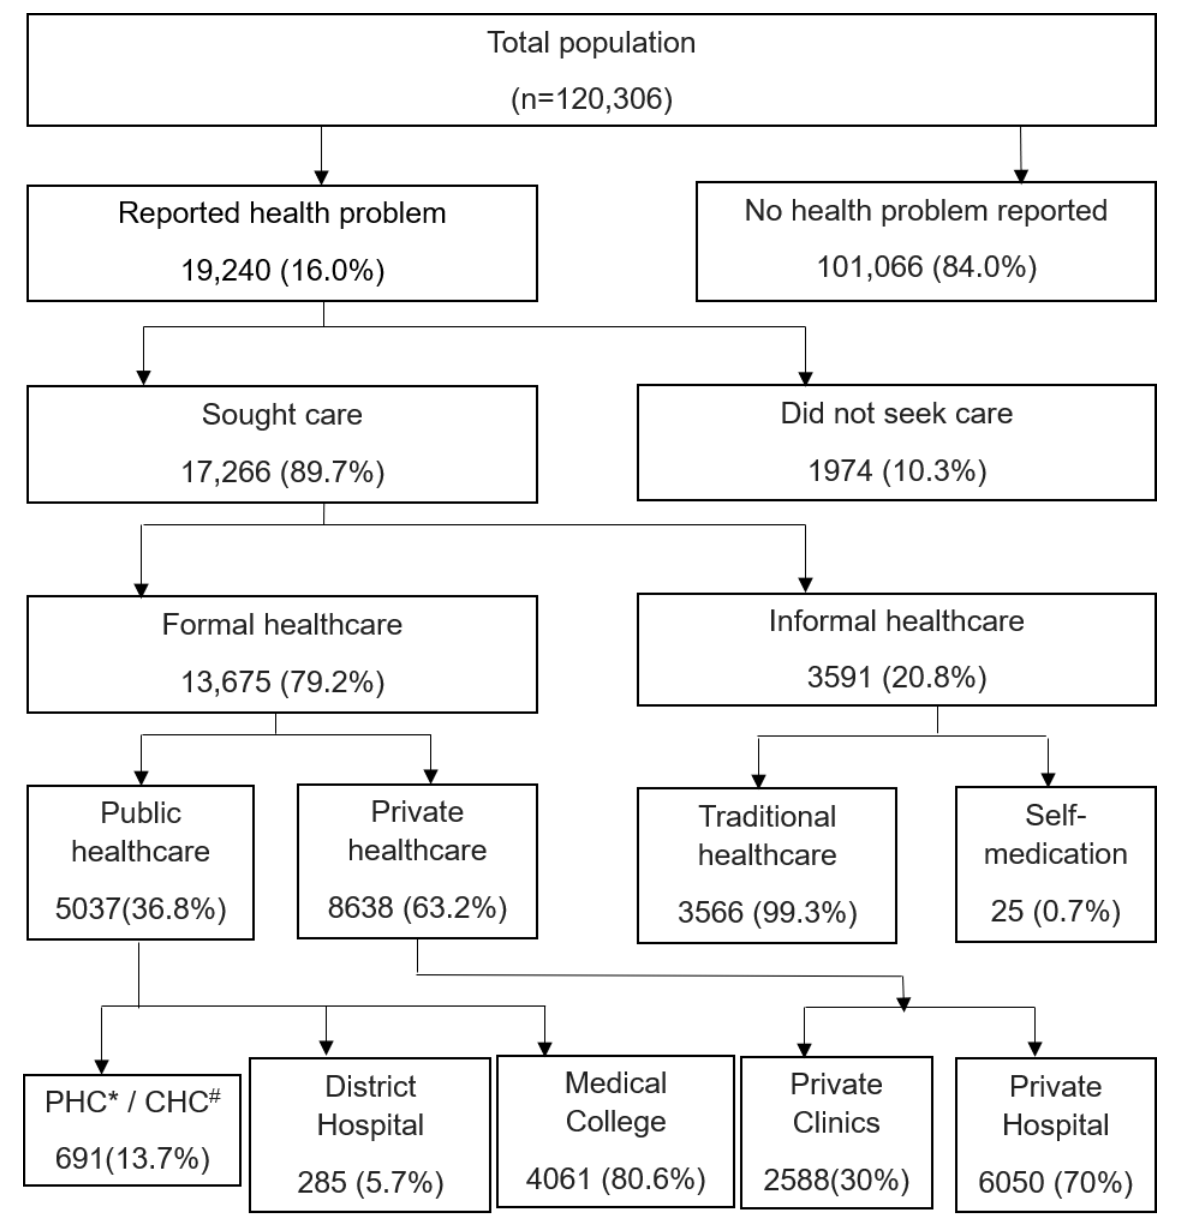
Figure 1. Flow diagram depicting health-seeking behaviour and healthcare utilization among people of GHDSS cohort ( n = 120,306). * PHC, primary health centre; # CHC, community health centre.